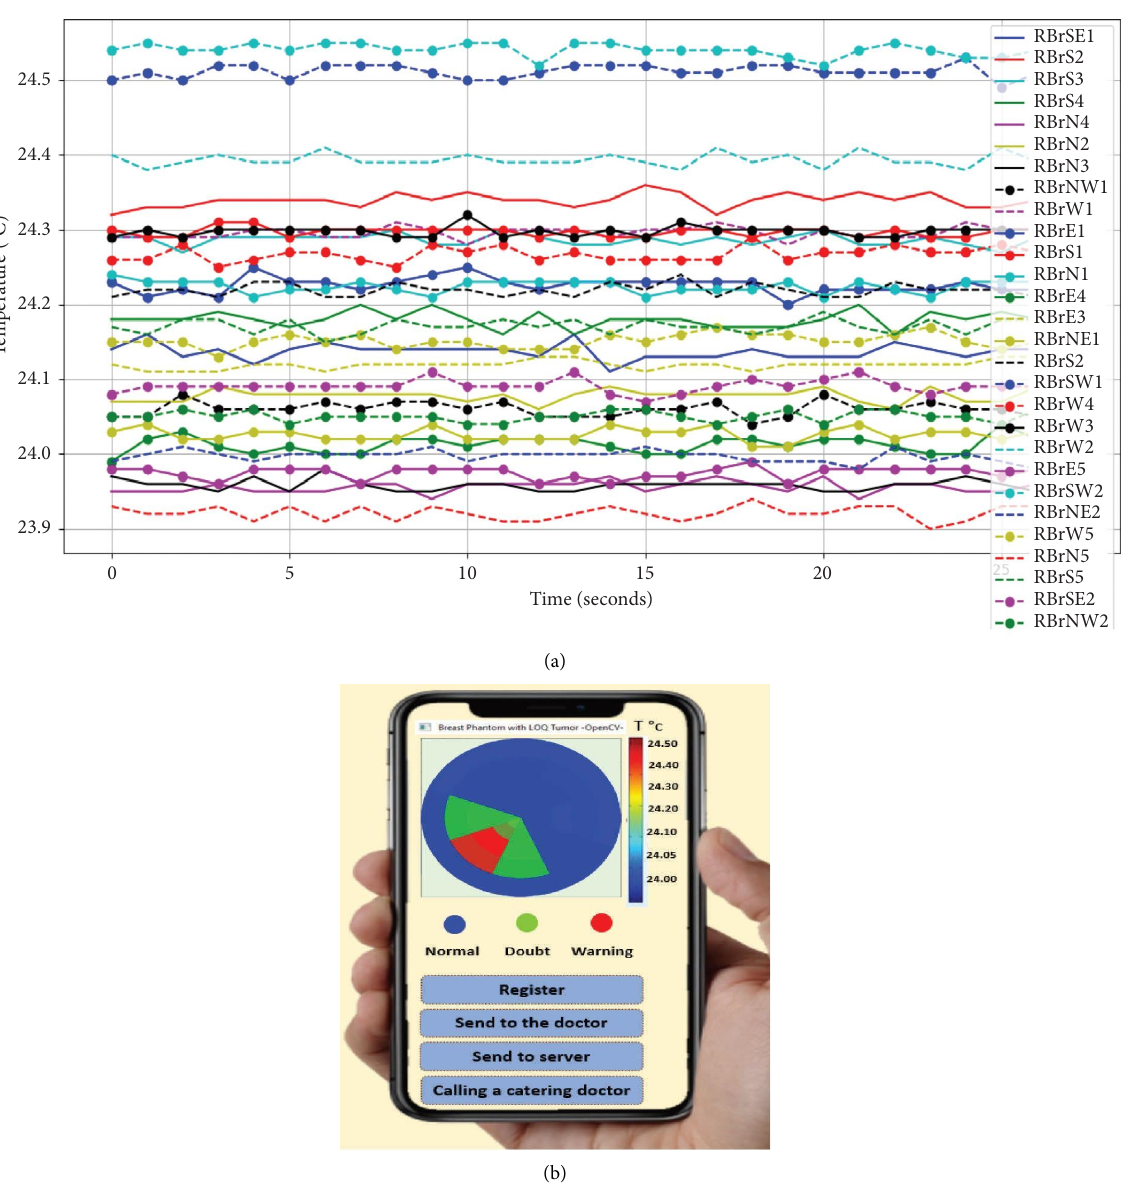
Figure 15: Temperature distribution of the right breast phantom with a lower outer quadrant (LOQ) tumor integrated at 20mm (a) Variation in several bioheat microsensors and (b) thermal distribution with OpenCV on smartphone